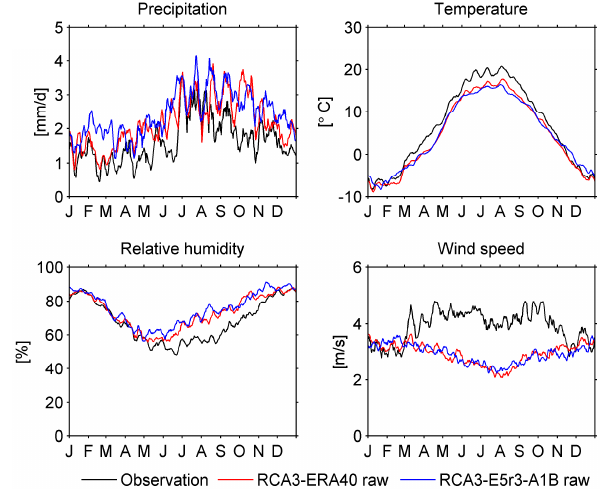
Figure 2. Seasonal variation of the FWI inputs (precipitation, tem- perature, relative humidity and wind speed) presented as 7-day moving average values at the Edsbyn station (see Fig. 1). Compar- ison of observational data and raw output of the climate models from RCA3-ERA40 and RCA3-E5r3-A1B simulations (calibration period